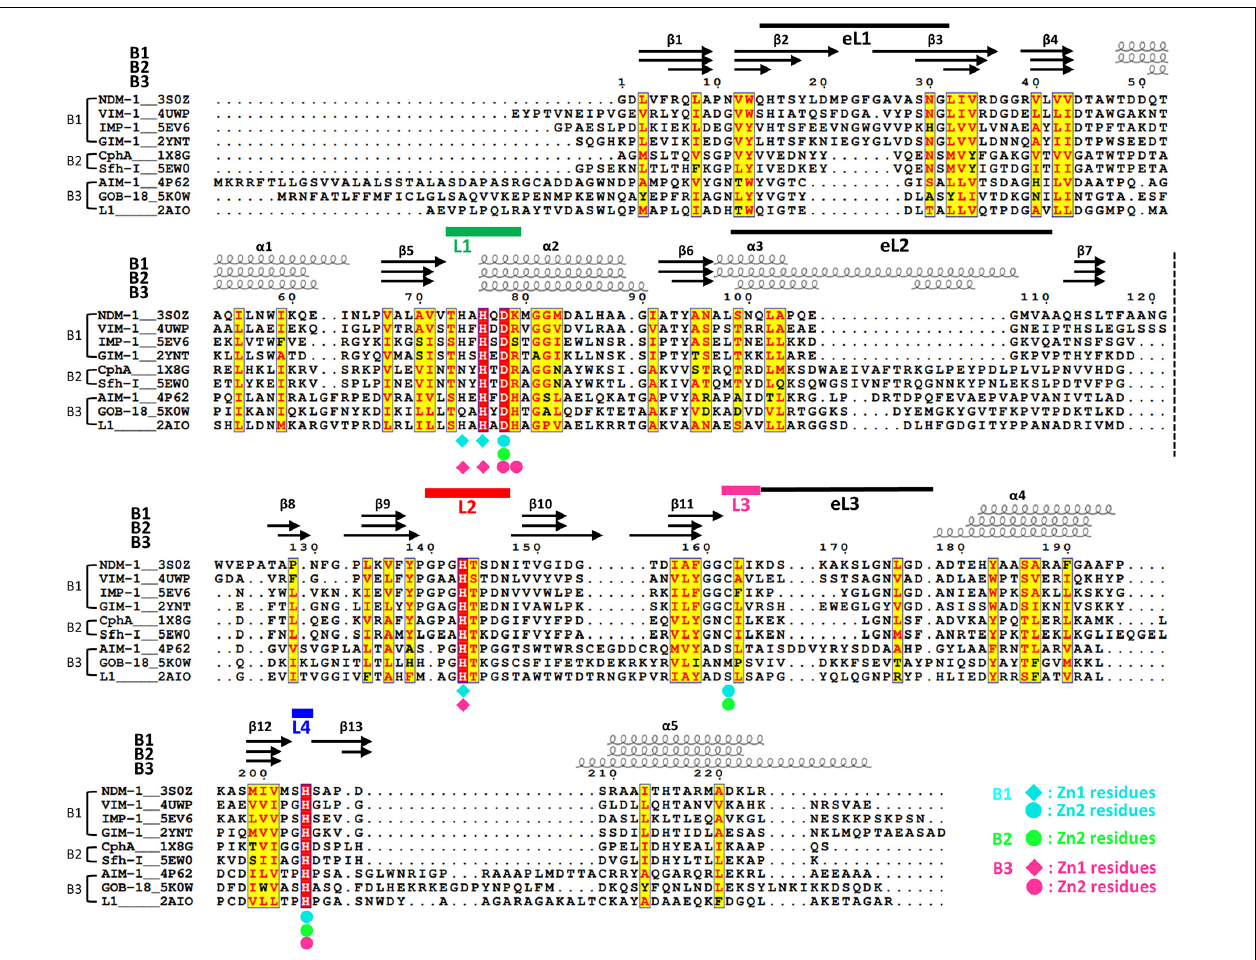
FIGURE 2 | The structural sequence alignment of MBLs. The secondary structures of NDM-1, CphA, and AIM-1 are shown at the top. The labels B1, B2, and B3 show the representative member of each subclass. The numbering of secondary structures is based on the core scaffold of 13 β -strands and 5 α -helices. In some B3 MBLs, including AIM-1, an additional α -helix ( α 3 (cid:48) ) exists after α 3. The first and second halves of the αβ / βα sandwich fold are divided by a dashed line between the β 7 and β 8 strands. The zinc-coordinating residues of the B1, B2, and B3 subclasses are shown as diamonds and circles in cyan, green, and pink, respectively. The four zinc-coordinating loops L1, L2, L3, and L4 are shown as thick green, red, pink, and blue lines, respectively. The three external loops eL1, eL2, and eL3 are shown as thin black lines.